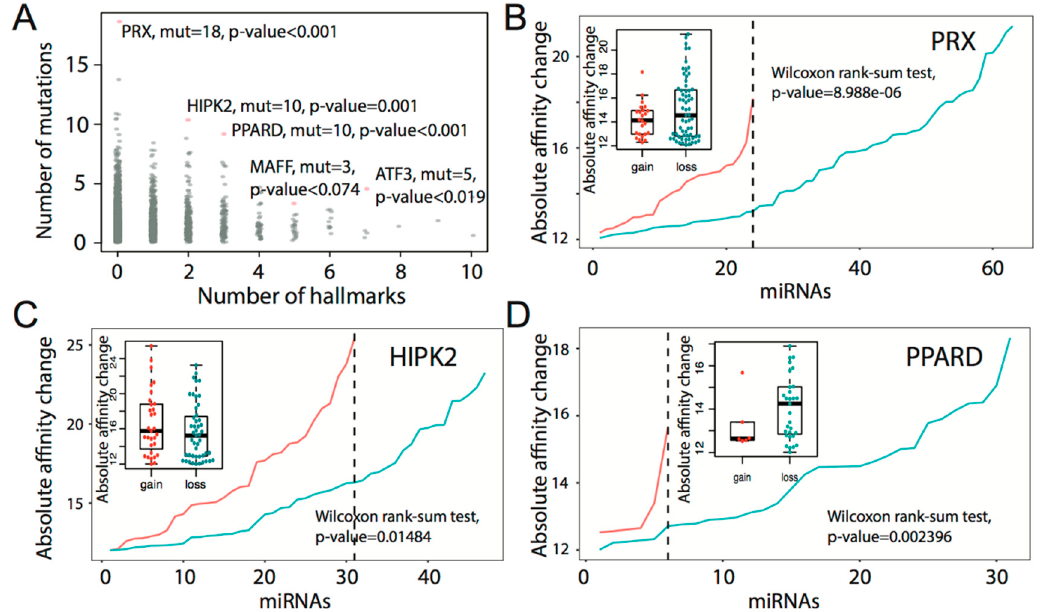
Figure 4. ( A ) Number of hallmarks versus number of mutations across tarGenes. Each tarGene was subjected to permutation analysis for significance evaluation. ( B – D ) Differential analysis of affinity changes between loss and gain of 3 ′ UTR mutation in PRX, HIPK2, and PPARD. Blue and red lines represent the absolute affinity change of loss and gain, respectively.